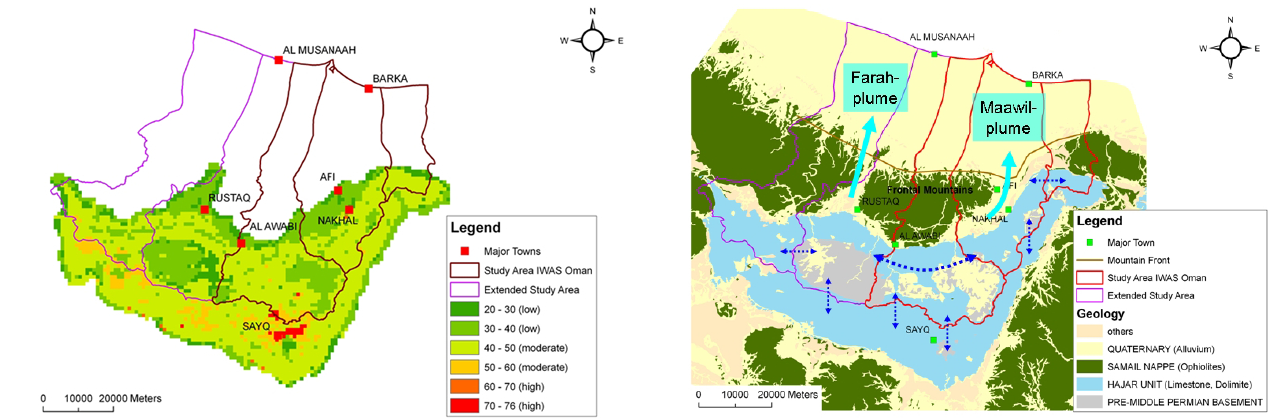
Fig. 4. APLIS recharge rates for the study area in % of annual pre- cipitation.